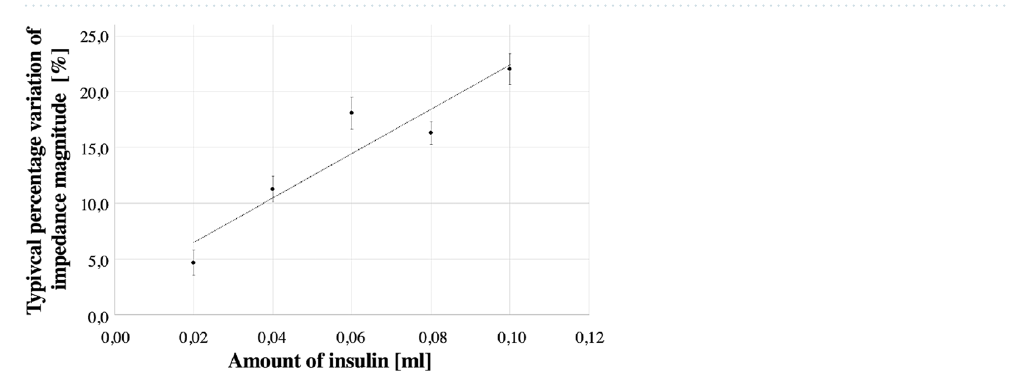
Figure 8. Typical percentage magnitude variation versus insulin solution in ex-vivo